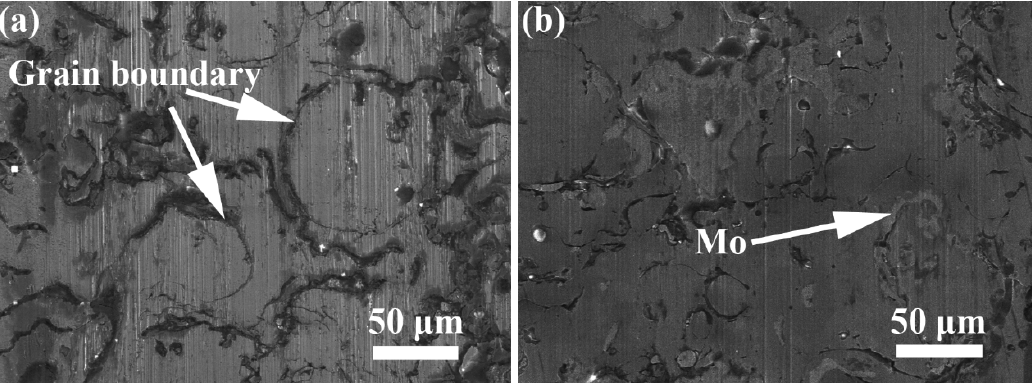
Figure 8. SEM morphologies of worn surfaces of NiCrAlY ( a ) and NiCrAlY-Mo ( b ) coatings after friction tests in artificial seawater.